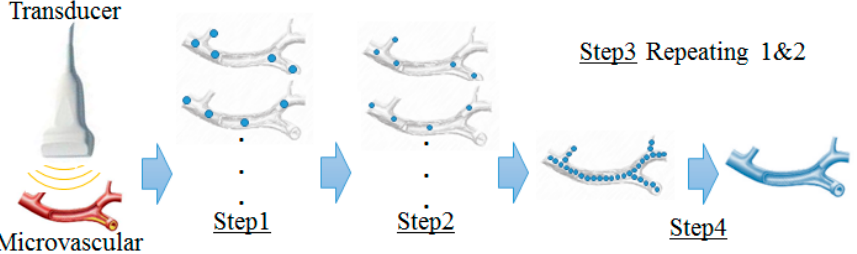
Figure 1. Super-resolution imaging process: Step 1. Scanning and comparing, Step 2. Microbubble localization, Step 3. Repeating 1 & 2 for each frame, Step 4. Trajectory tracking.